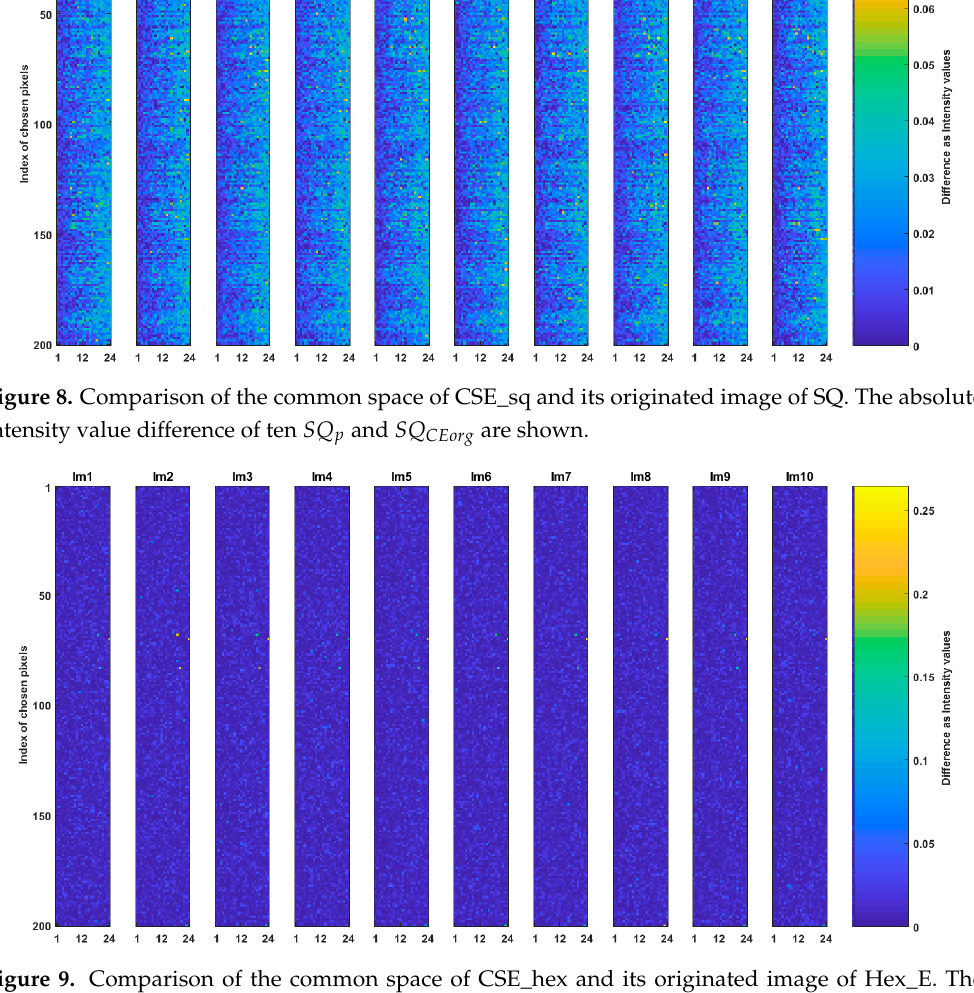
Figure 9. Comparison of the common space of CSE_hex and its originated image of Hex_E. The absolute intensity value difference of ten Hex _ E p and Hex _ E CEorg are shown.